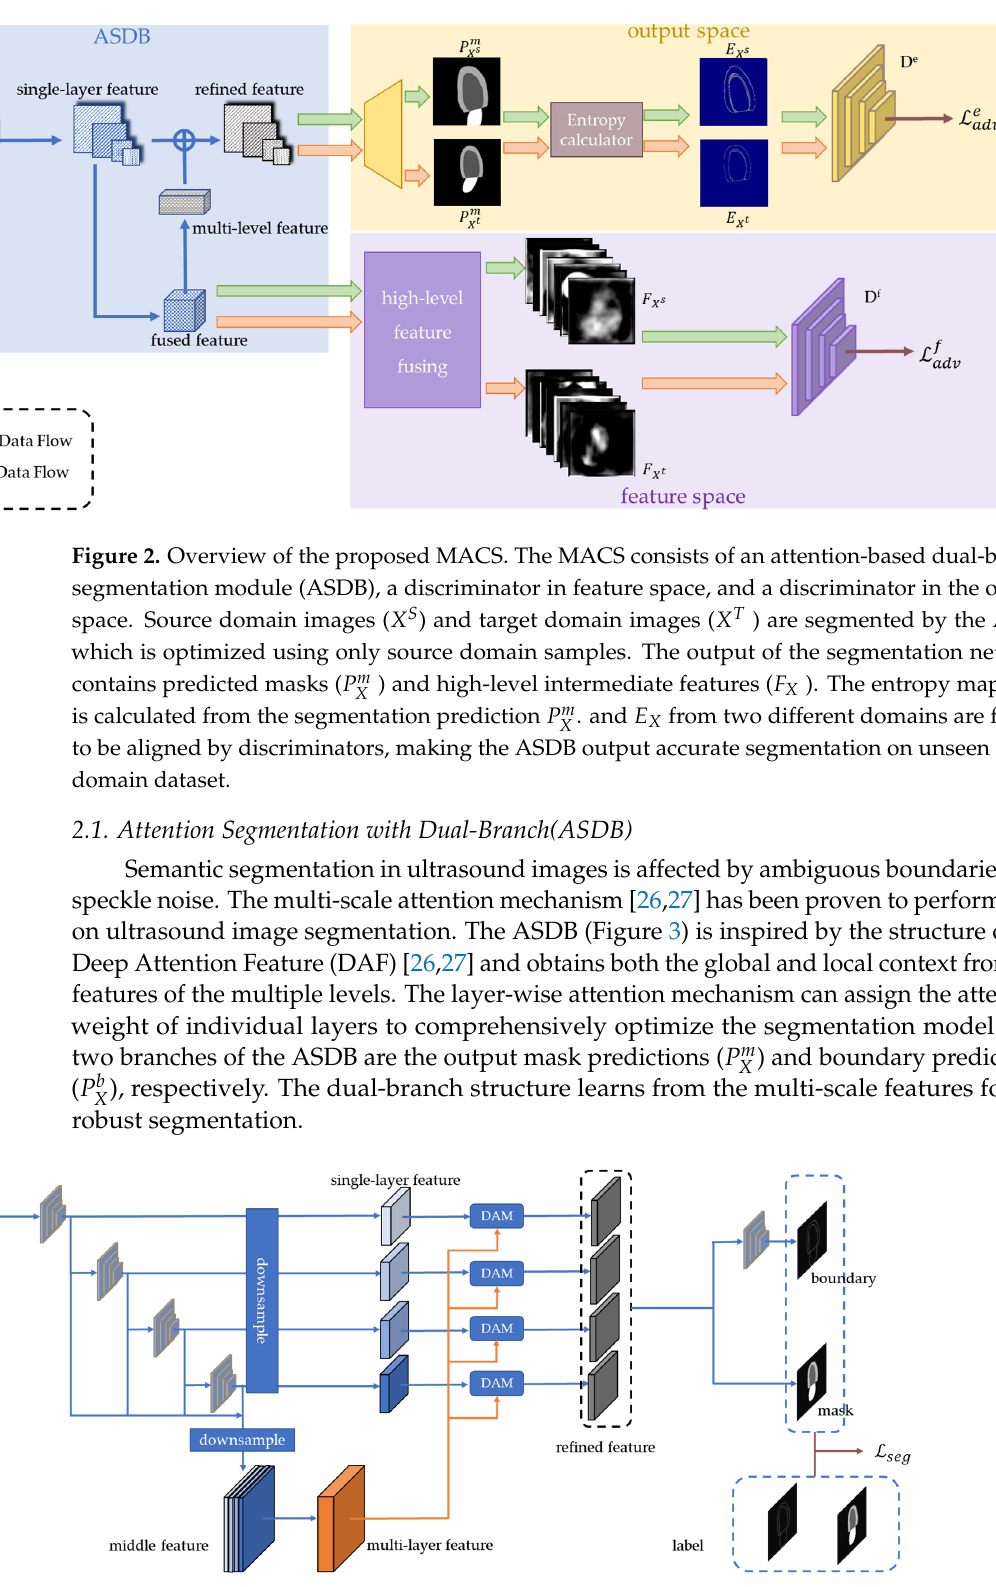
Figure 3. The architecture of the Attention Segmentation with the Dual-Branch (ASDB) module. The encoder extracts multiply single-layer feature maps. The multi-layer feature is the fusion of these feature maps. Single-layer features and multi-layer feature pass by the deep attention model (DAM) for the refined feature. The dual-branch structure generates the prediction of the mask and bound- ary.